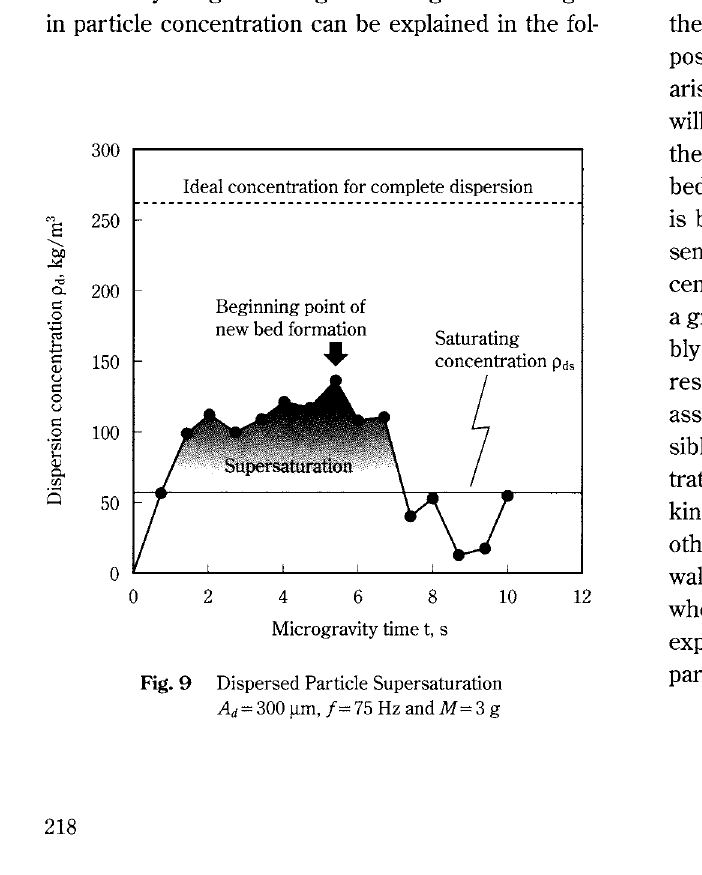
Microgravity time t, s Dispersed Particle Supersaturation Ad=300 )lm, !=75Hz andM=3 g